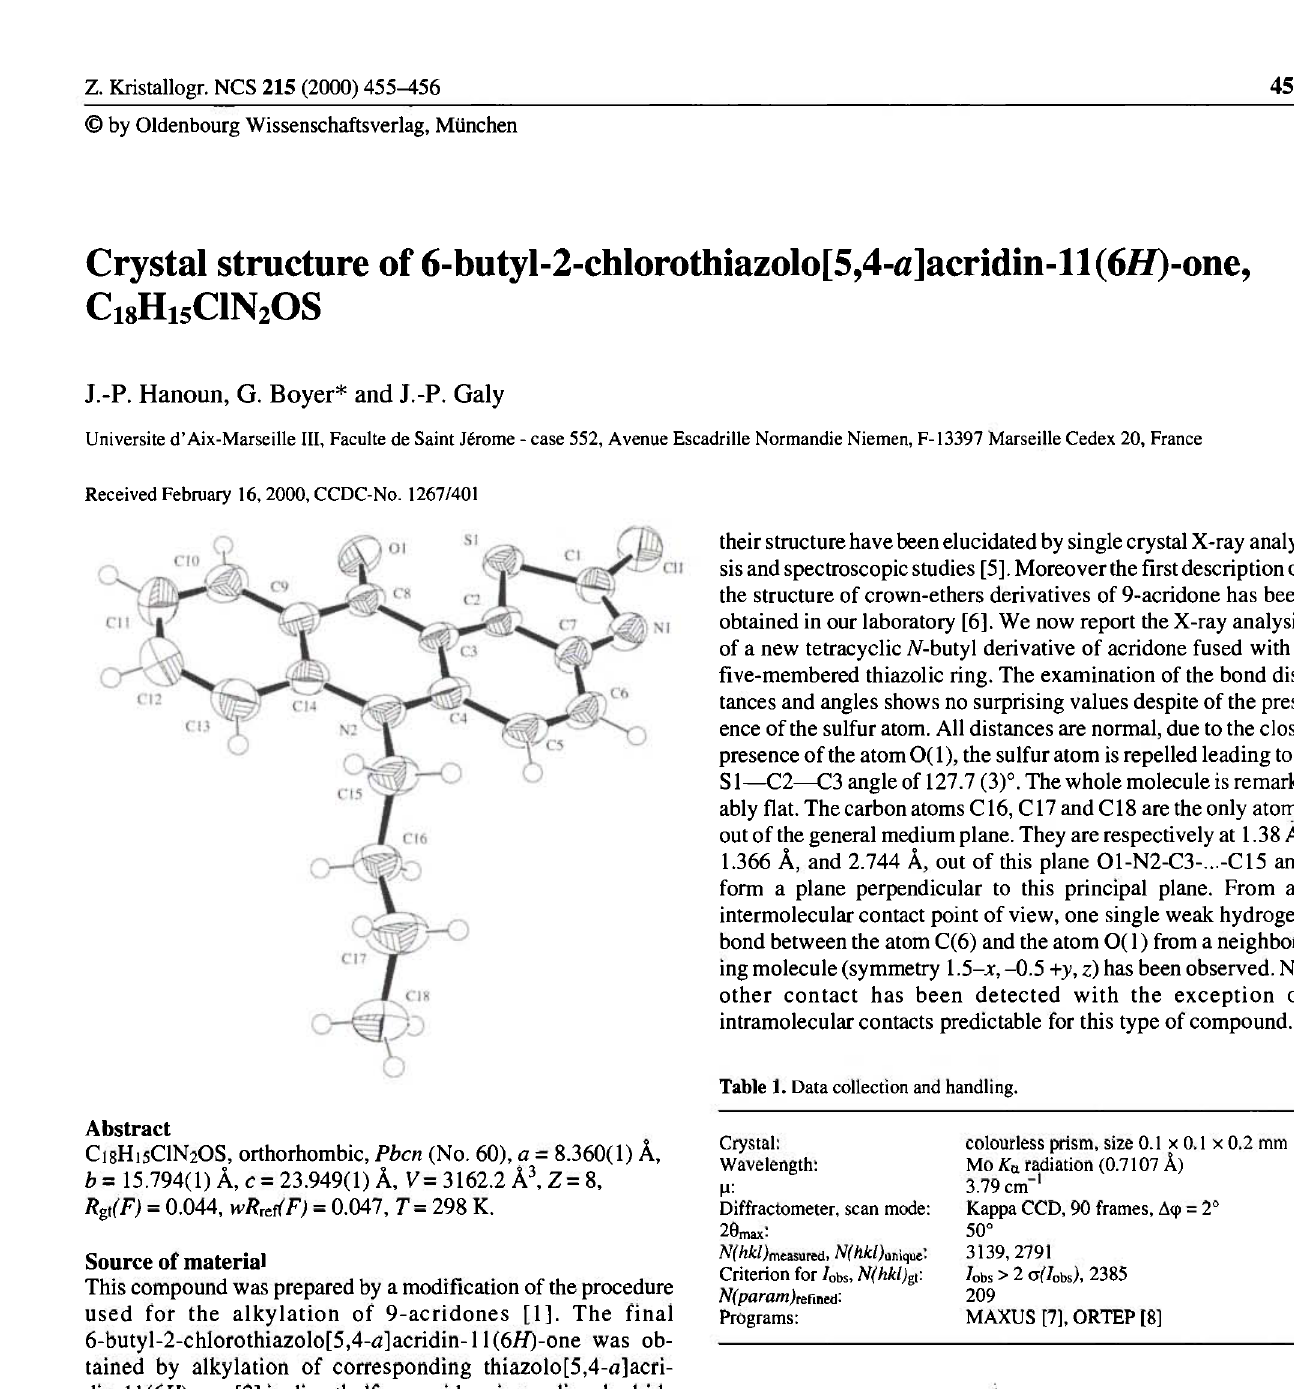
Table 2. Atomic coordinates and displacement parameters (in Ä 2